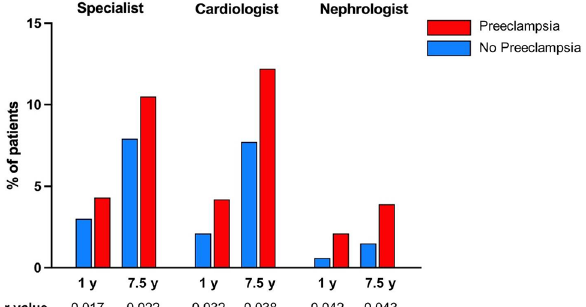
Figure 2. Relative number of patients who consulted a specialist for internal medicine, cardiologist, or nephrologist during follow-up stratified for the occurrence of PE. Data are presented as cumulative percentages of patients with (red) and without preeclampsia (blue) and were compared using χ 2 test with Yates’ continuity correction; r values > 0.1 indicate a weak association. P values not shown, as for each p <